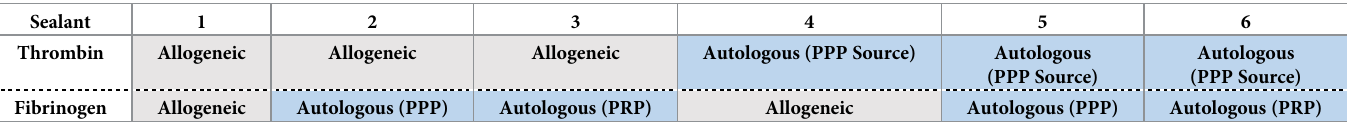
Table 1. Fibrin sealants evaluated for failure